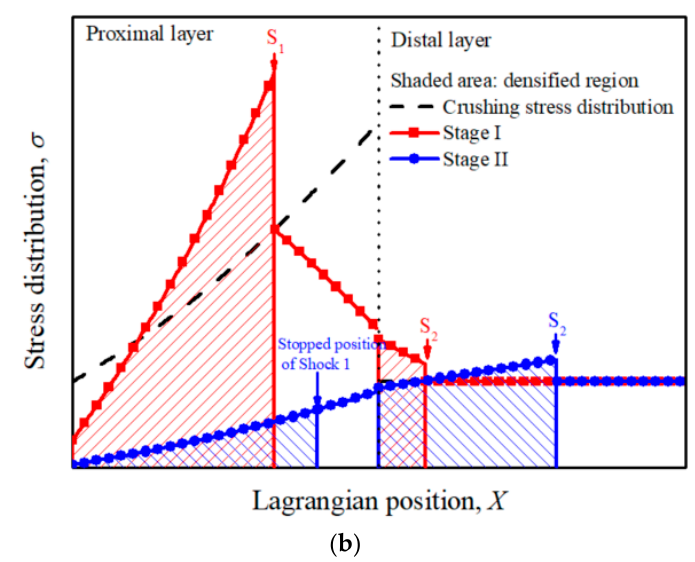
Figure 3. ( a ) The deformation diagram and ( b ) the stress distributions of PG-U cladding subjected to blast loading.